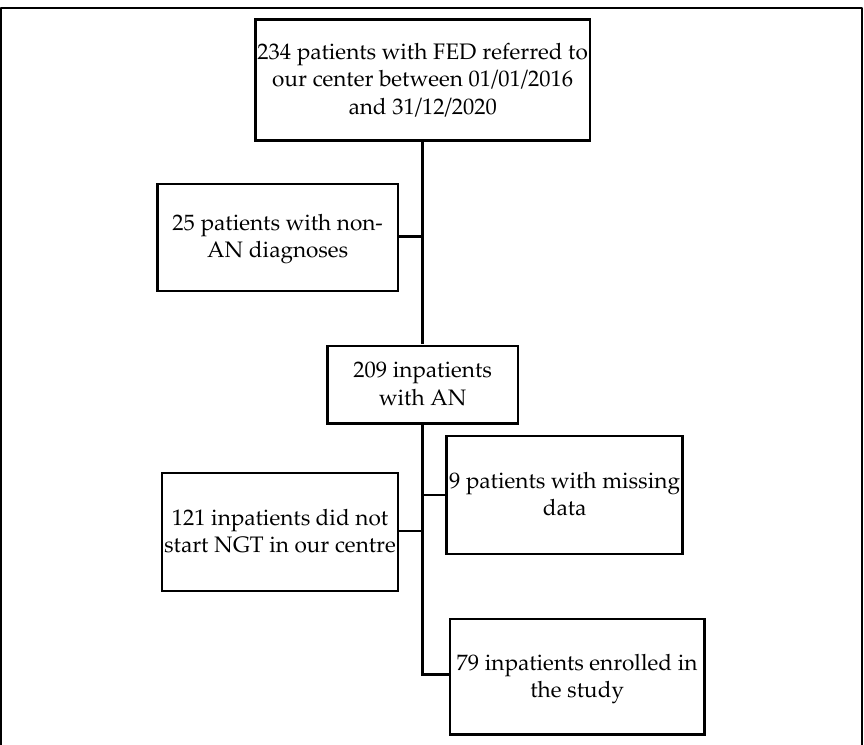
Figure 1. Flowchart of the study. Abbreviations: AN: anorexia nervosa; FED: feeding and eating disorders; NGT: naso-gastric tube; FED: feeding and eating disorders.